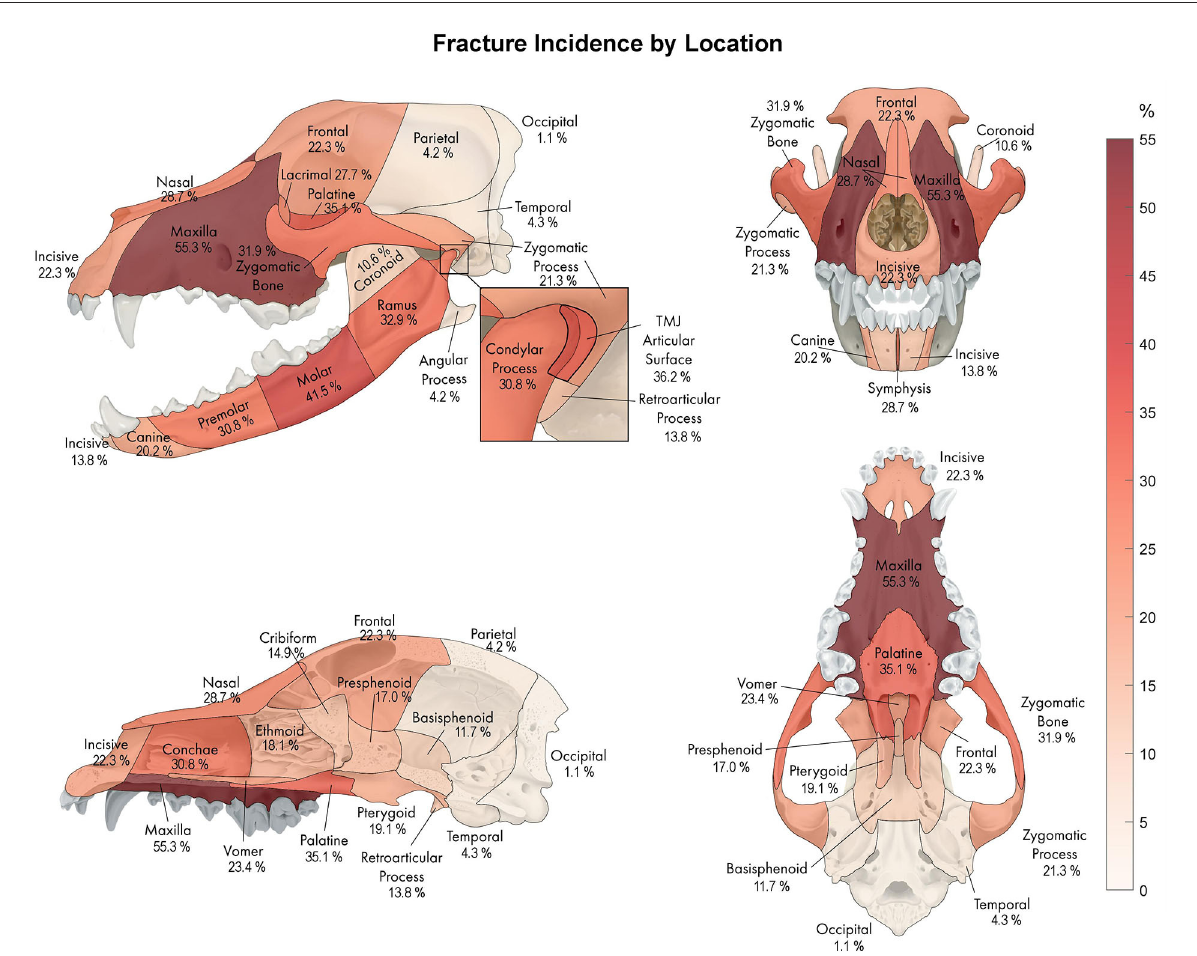
FIGURE9 A percentage heat map demonstrating the proportion of CMF fracture locations. Percentages represent the percentage of dogs sustaining a fracture in each location. For example, 55.3% of dogs in this study sustained fractures of the maxillary bone, whereas 1.1% of dogs in this study sustained fractures of the occipital